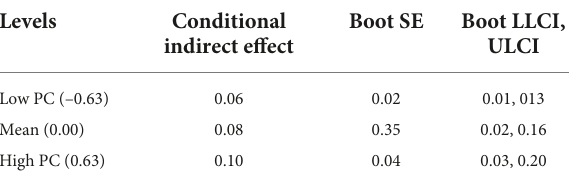
TABLE 4 Conditional indirect